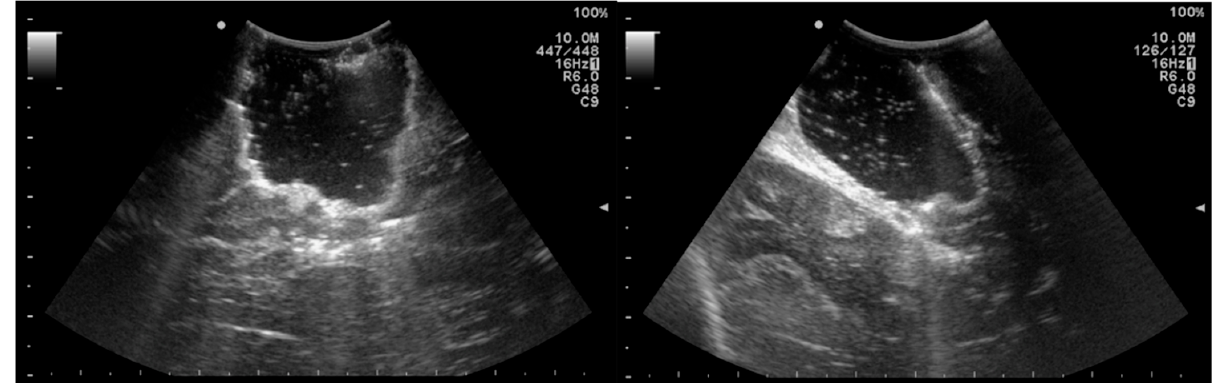
Figure 2. Use of intraoperative ultrasound in a 22-year-old patient with glioblastoma. Axial view ( left ) and coronal view ( right ). ( left ) and coronal view ( right